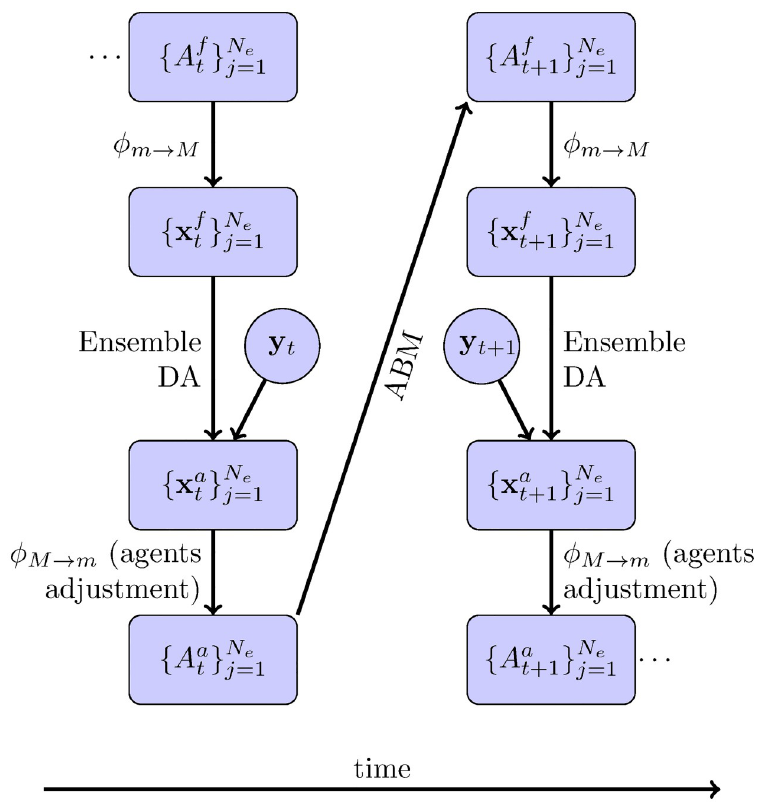
Fig 2. Ensemble based DA for